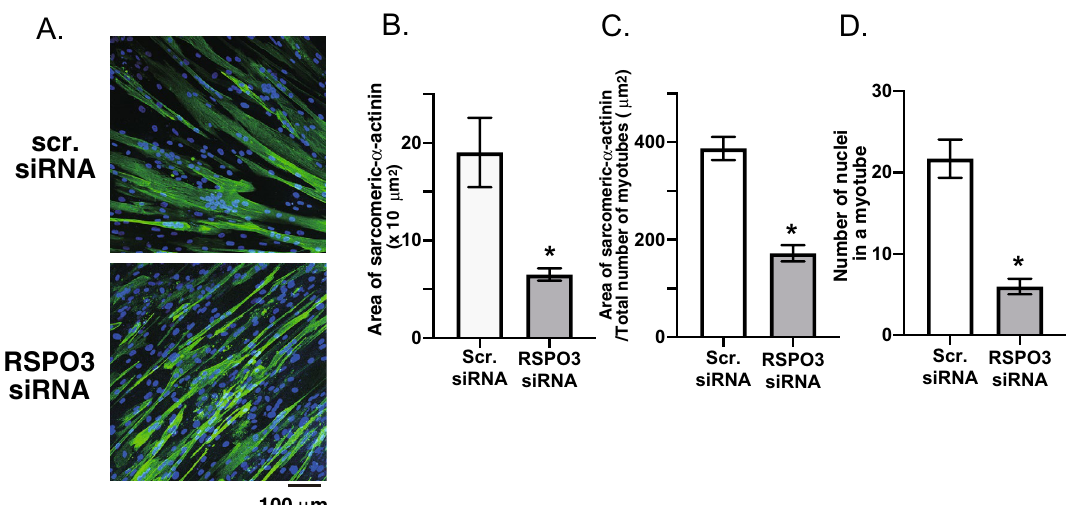
Figure 5. Effect of siRNA-mediated R-spondin 3 (RSPO3) silencing on human myotube formation. ( A ) The siRNAs against RSPO3 or control scramble RNAs were transfected twice into human myoblasts on day 0 and on day 2, and then cultured further for total 7–8 days in differentiation medium. Fixed cells were subjected to immunofluorescent staining using anti-sarcomeric-α-actinin antibody ( green ). Three independent experiments were performed and representative images are presented. The total area of sarcomeric-α-actinin-positive fluorescent signals per field of view ( B ), area of sarcomeric-α-actinin-positive fluorescent signals in a human myotube ( C ), and numbers of nuclei in a myotube ( D ) were evaluated as described in the Methods. Summarized graphs averaged over 3 independent experiments are shown on the right (* P < 0.05).